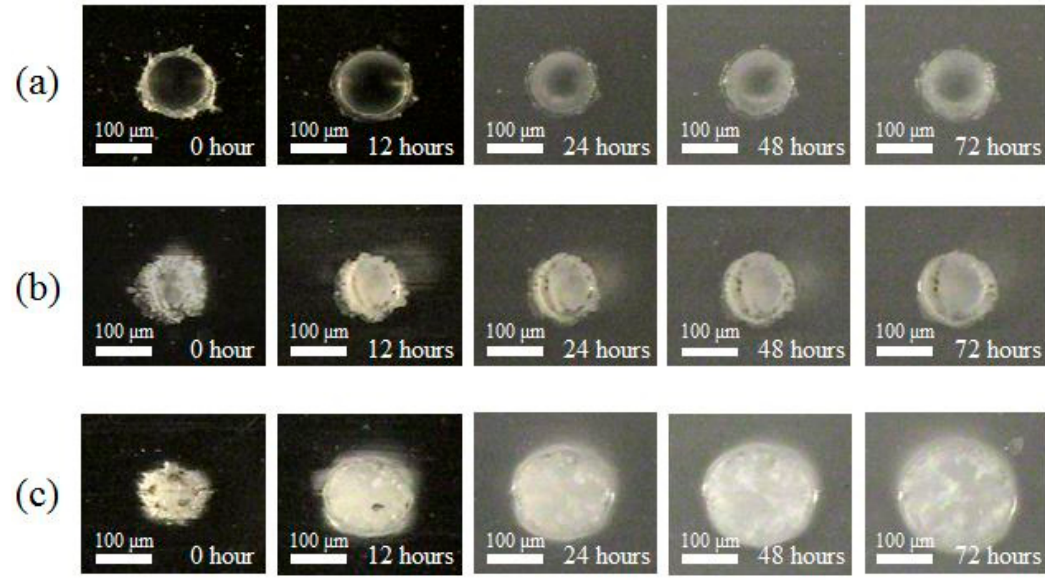
Figure 3. Digital microscopic images of craters formed on PLGA films. The time shown in each figure indicates the time of the samples immersed in PBS at 37 °C. ( a ) Crater formed by mechanical milling. ( b ) Laser ablation crater under the condition of 800 nm wavelength, 1.0 J/cm 2 , 15,000 pulses. ( c ) Laser ablation crater under the condition of 400-nm wavelength, 0.15 J/cm 2 , 15,000 pulses. Laser fluences were carefully selected to fabricate laser ablation craters of the same diameter to minimize the initial difference in the diameter.